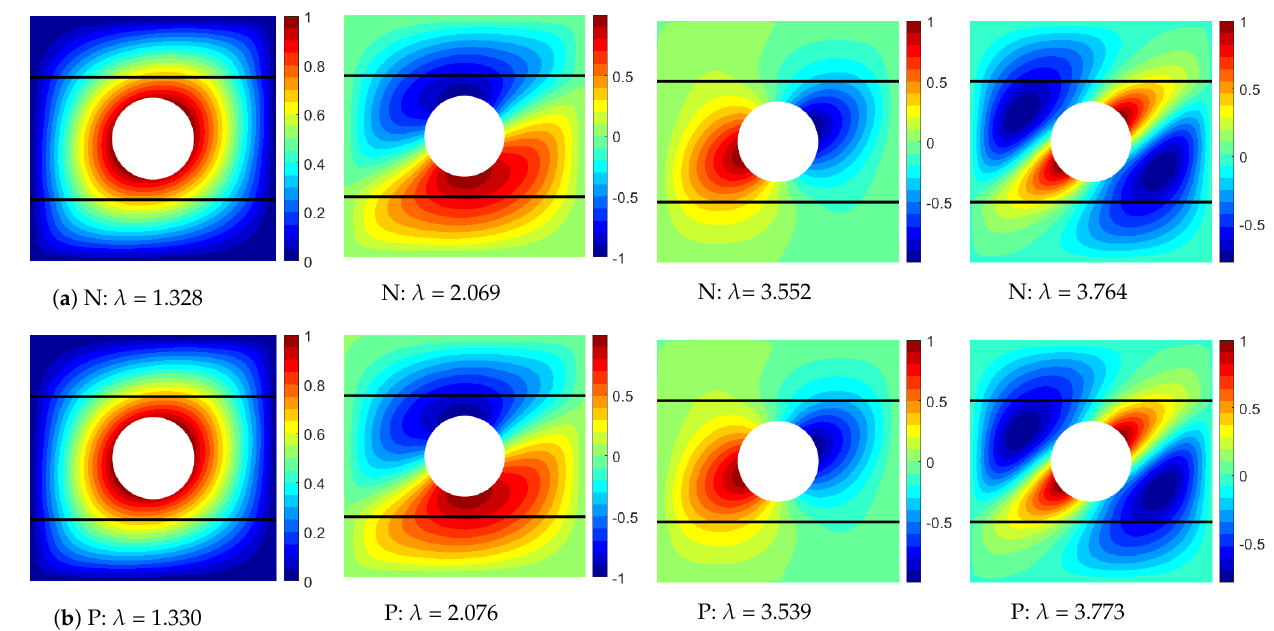
Figure 10. Comparison of buckling eigenvalue ( λ ) and buckling mode shapes of the stiffened VAT laminates with a central hole under uniform axial displacements. ( a ) N: NASTRAN results; ( b ) P: Present results.